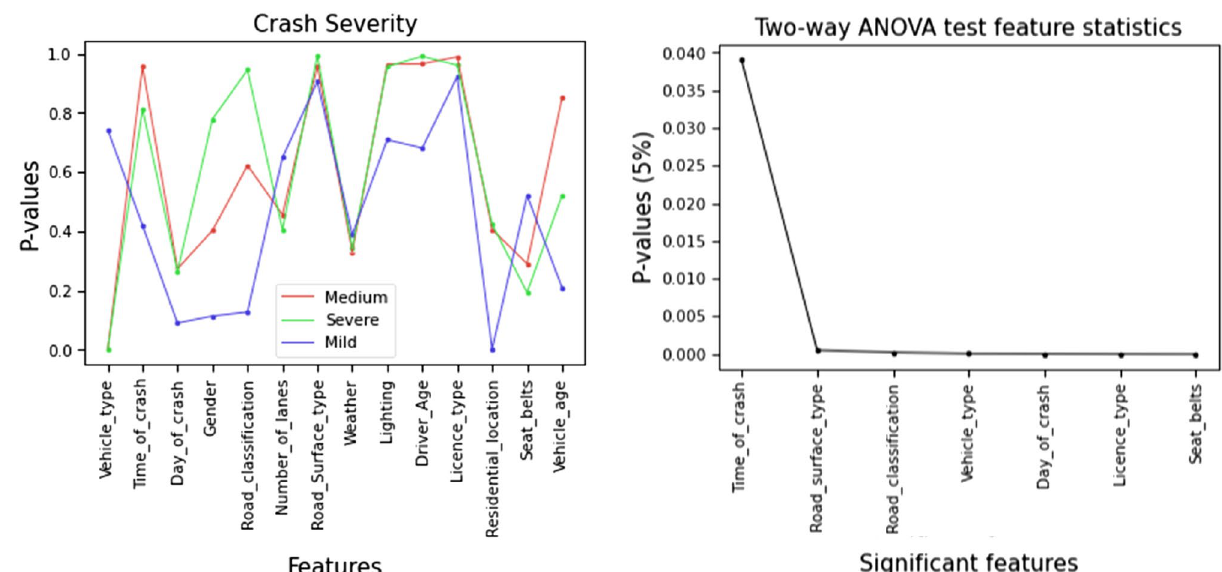
Figure 5. Two-way ANOVA test feature classification for significant feature